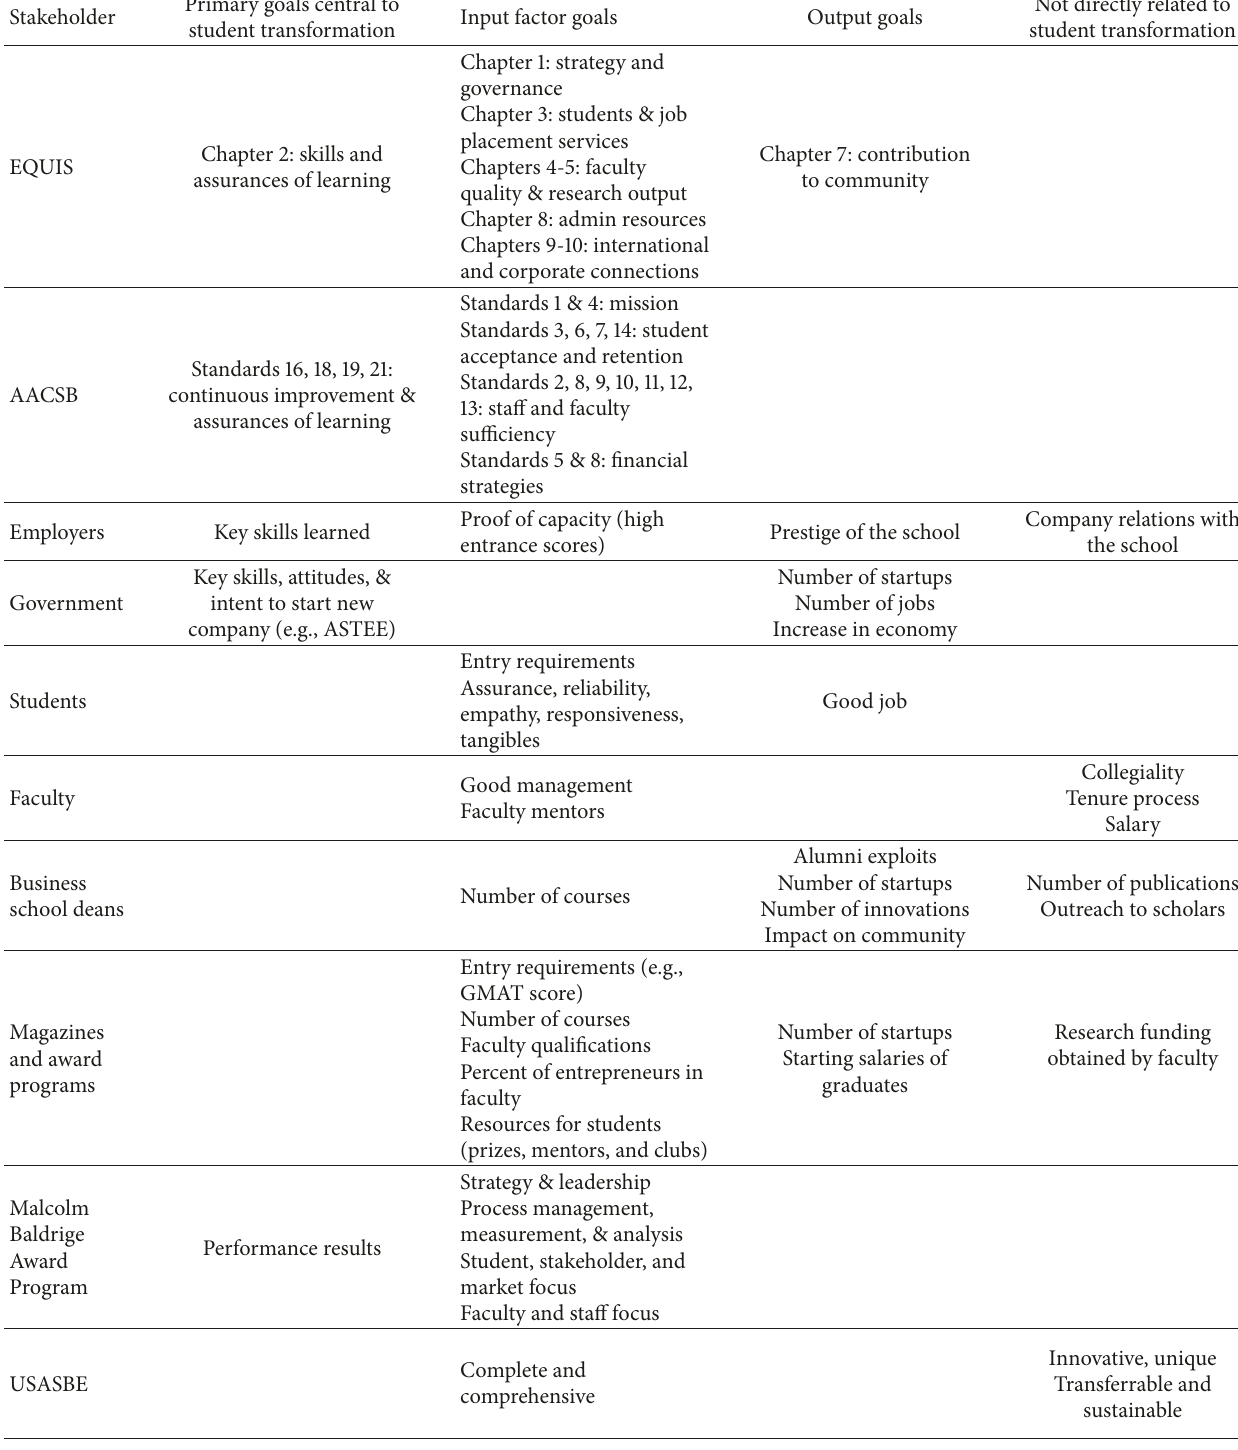
Table 1: Classification of quality expectations of alternative